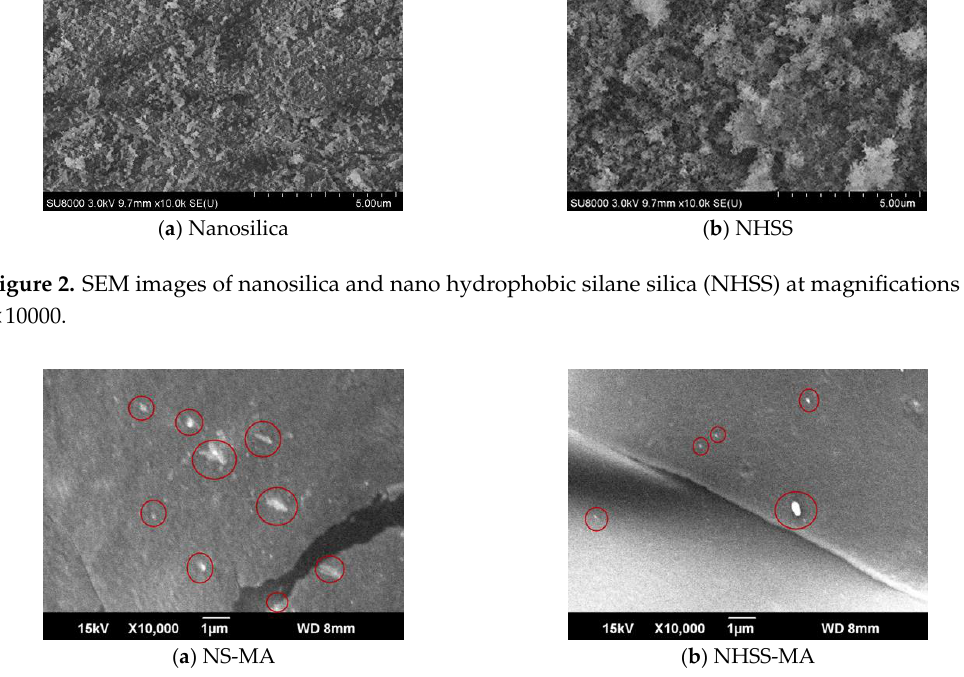
Figure 3. Scanning electron micrographs of nanosilica modified asphalt and NHSS modified asphalt.